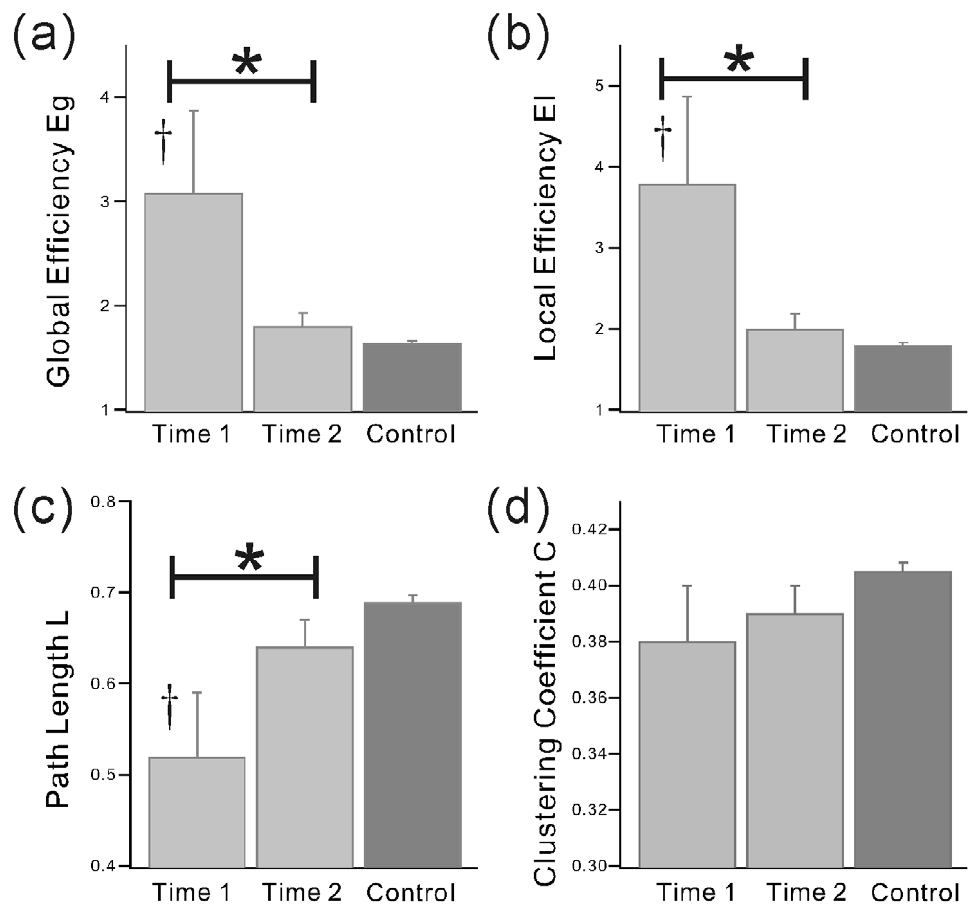
Figure 3. Functional Network properties of weighted networks (1). The weighted network properties; (a) Global efficiency Eg , (b) Local efficiency El , (c) Characteristic path length L , and (d) Clustering coefficient C , from TBI and Control groups. Here, the value of weight w i , j for each edge e i , j in the network was defined as w i , j ~ 1 { r i , j , where r i , j is the absolute partial correlation coefficient between region i and j . * indicates significant difference between Time 1 and Time 2. { indicates significant change from control group.